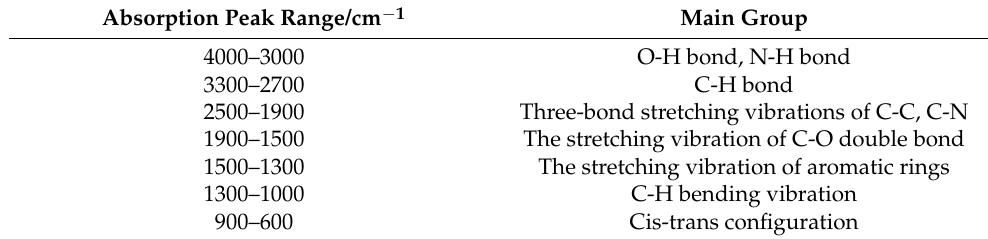
Table 6. Absorption peak range of each group.